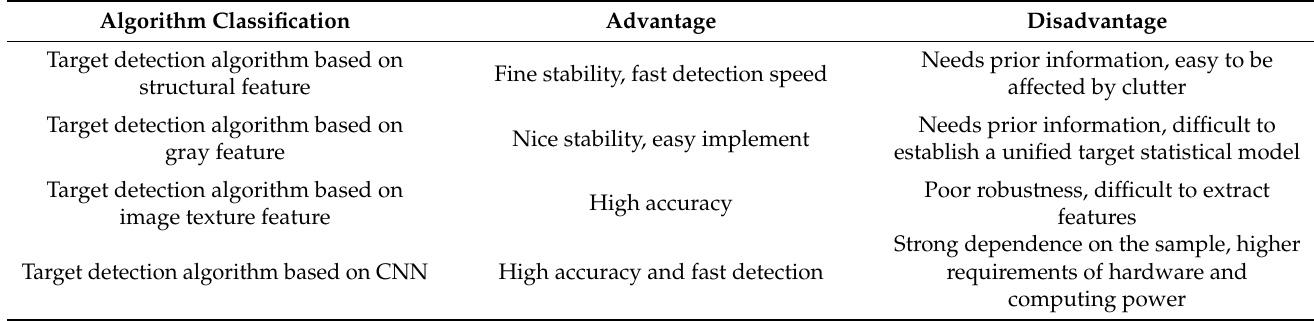
Table 9. Comparison table of SAR image target detection algorithms. Algorithm Classification Advantage Disadvantage Needs prior information, easy to be Target detection algorithm based on Fine stability, fast detection speed affected by clutter structural feature Needs prior information, difficult to Target detection algorithm based on Nice stability, easy implement gray feature establish a unified target statistical model Poor robustness, difficult to extract Target detection algorithm based on High accuracy features image texture feature Strong dependence on the sample, Target detection algorithm based on CNN High accuracy and fast detection